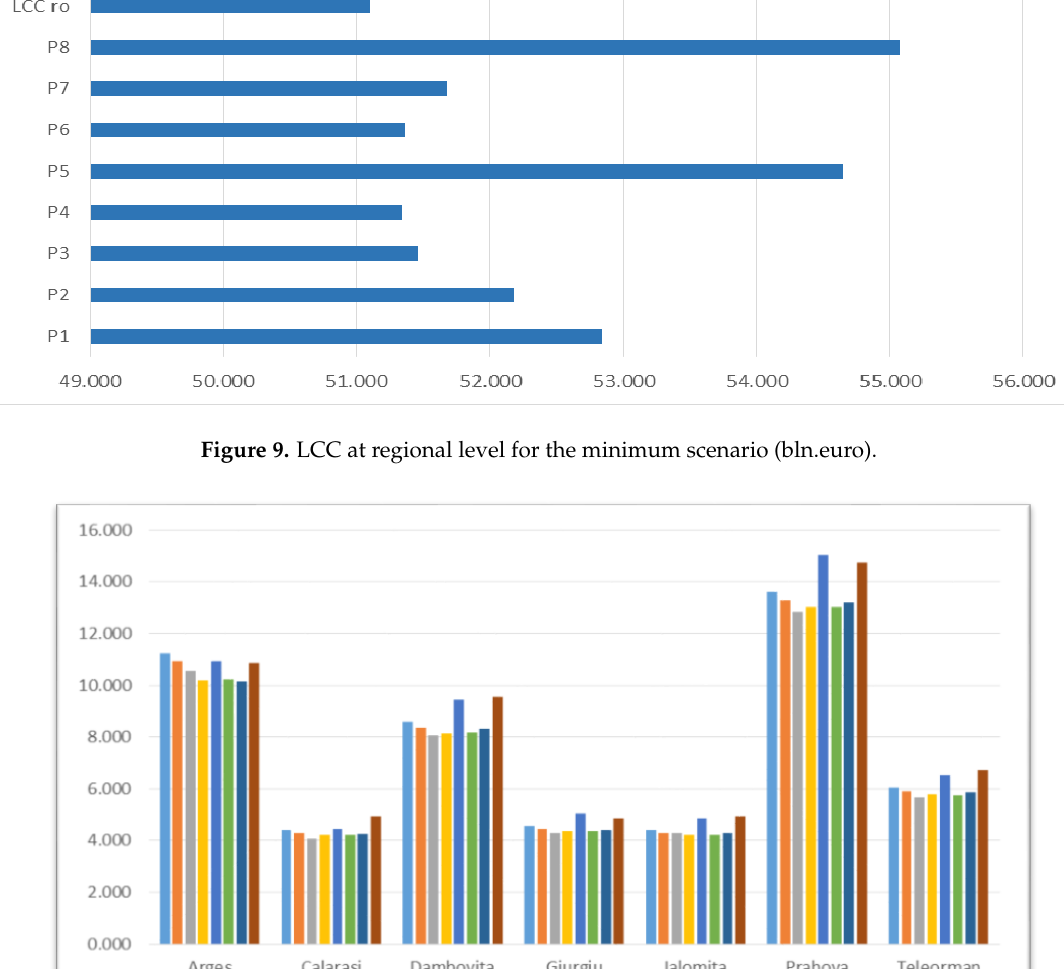
Figure 10. LCC at county level for the average scenario (bln.euro).